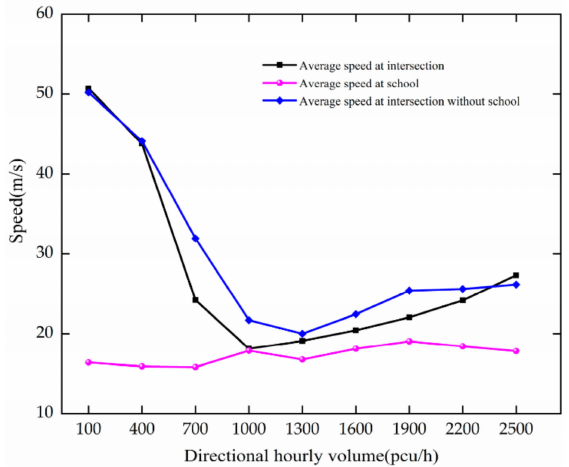
Figure 7. Variation trend of average speed with